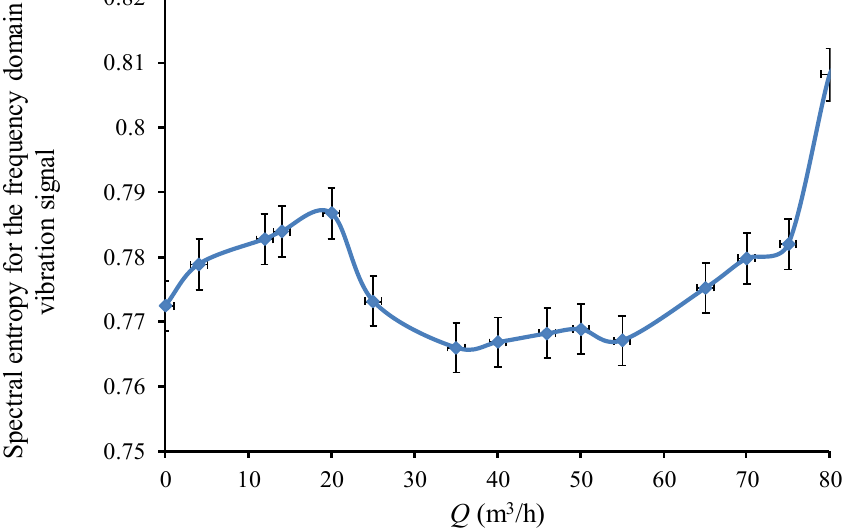
Figure 16. Kurtosis for the frequency domain vibration signal under different flowrates. Sensors 2020 , 20 , x FOR PEER REVIEW